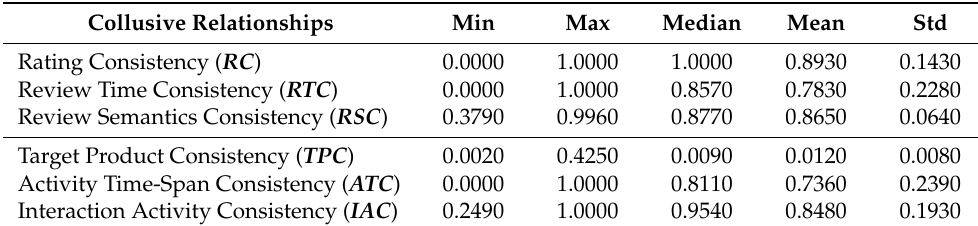
Table 4. Descriptive Statistical Analysis.